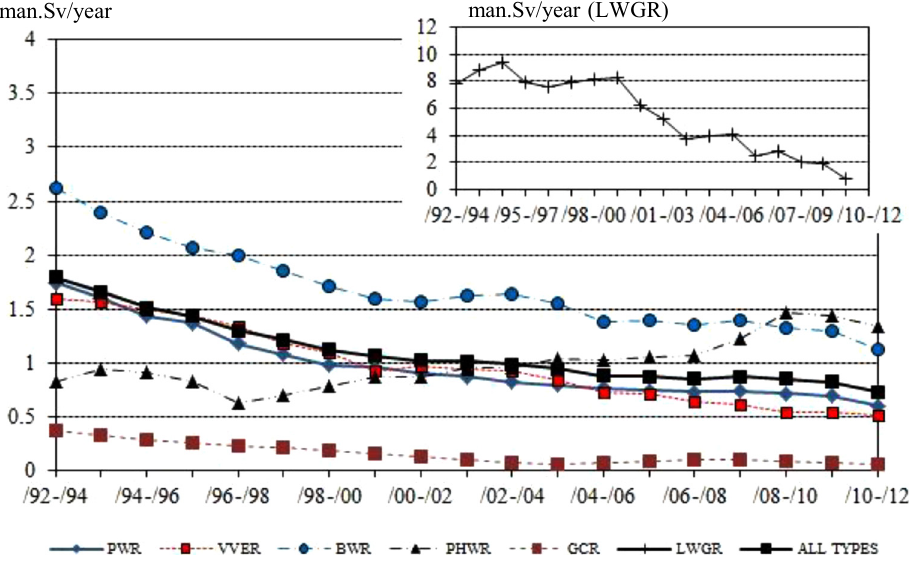
Fig. 4. Annual collective dose by type of reactor [1].